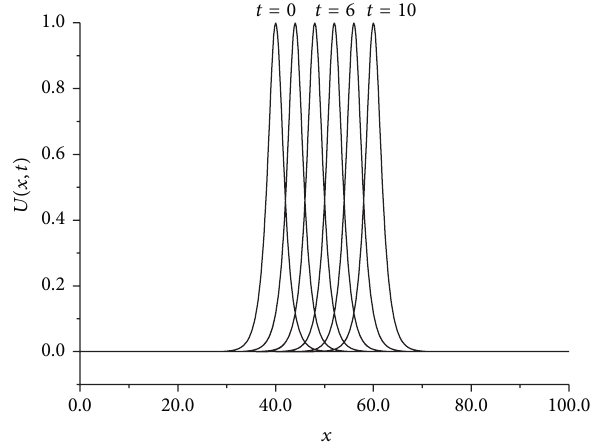
Figure 1: Single solitary wave with 𝑐 = 1, ℎ = 0.2, Δ𝑡 = 0.025, 0 ≤ 𝑥 ≤ 100 at times 𝑡 = 0,2, 4, 6, 8 , and 10 .